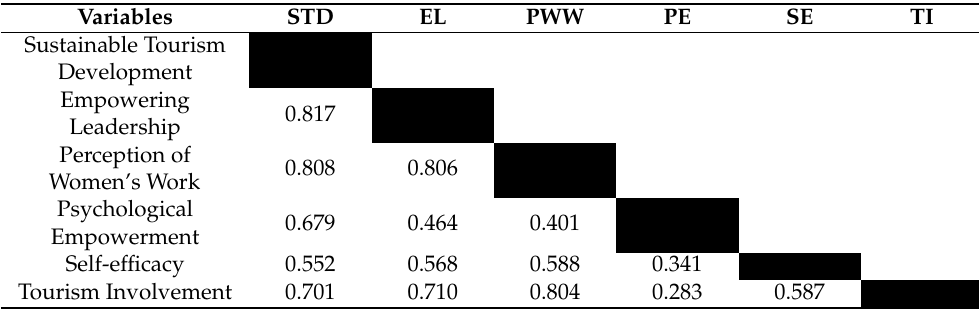
Table 3. Heterotrait–monotrait ratio